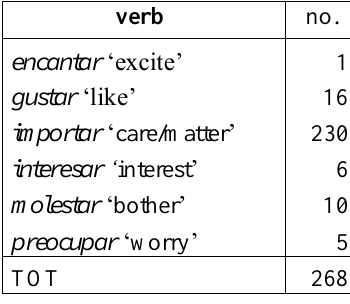
Table 1: Analyzed data according to the type of nonfinite psych verb verb